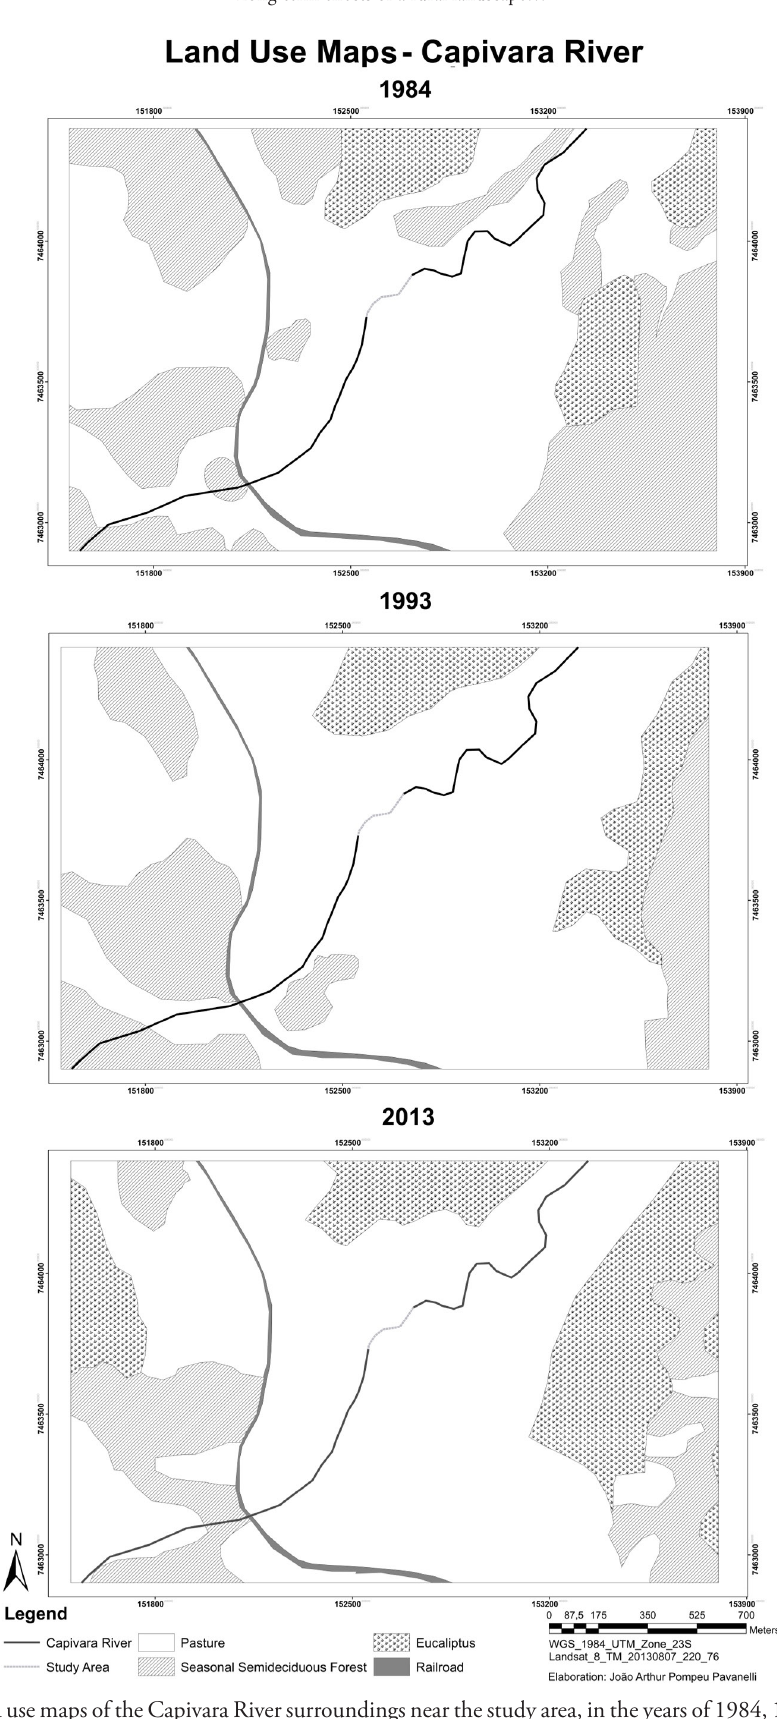
Figure 1. Land use maps of the Capivara River surroundings near the study area, in the years of 1984, 1993 and